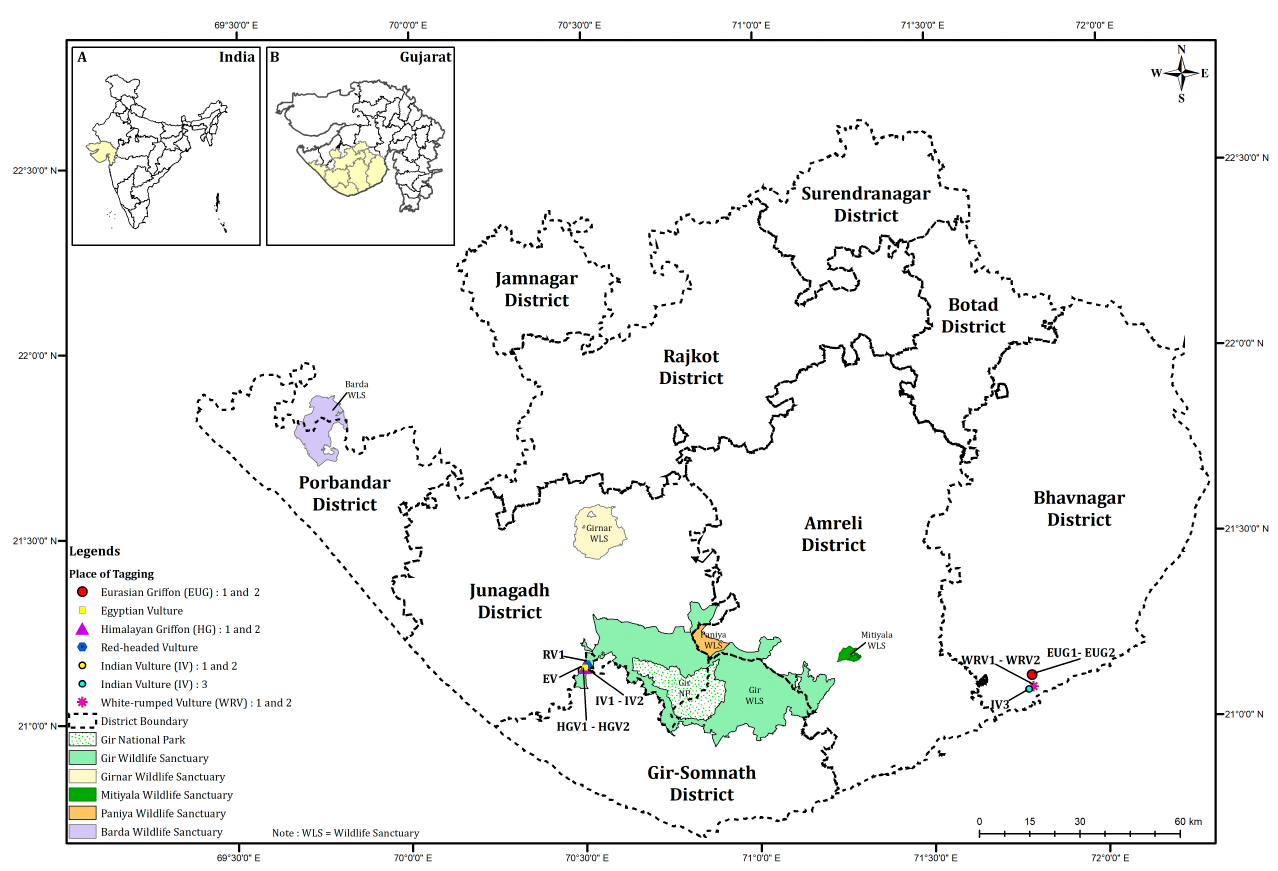
Figure 1. The location of the Asiatic Lion Landscape, Saurashtra, Gujarat, India. The map insets show the location of Gujarat State in India ( A ) and the Asiatic Lion Landscape in Gujarat State ( B ).